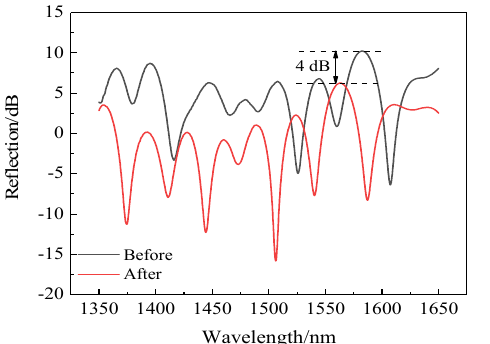
Figure 16. Spectra of the sensor before and after high-temperature annealing.